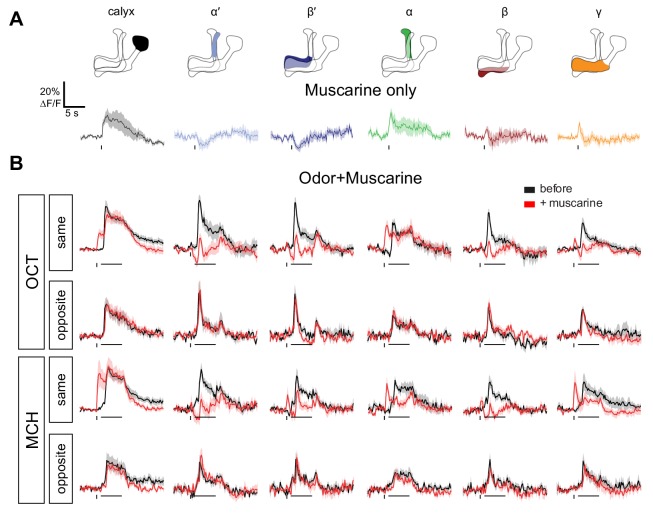
Local muscarine application to the calyx inhibits KC odor responses — all traces.Average ∆F/F GCaMP6f traces of the different MB regions of OK107 >GCaMP6f flies that only received the muscarine pulse (A) or received an odor pulse (MCH or OCT) before (black) or after (red) 10 ms pulse of 20 mM muscarine (B,C). Panel A is duplicated from Figure 6A; panel B is the traces corresponding to the Figure 6E. Muscarine was applied in the calyx, 1 s before the odor pulse where applicable. Traces are from the same side or the opposite side that muscarine was applied. Data are mean (solid line) ± SEM (shaded area). Horizontal bars indicate odor pulse timing and duration. Vertical bars indicate timing of muscarine pulse. n, by number of hemispheres (number of flies): same side MCH 6 (4), OCT 7 (5), opposite side MCH 5 (3), OCT 5 (3), muscarine alone 7 (5).